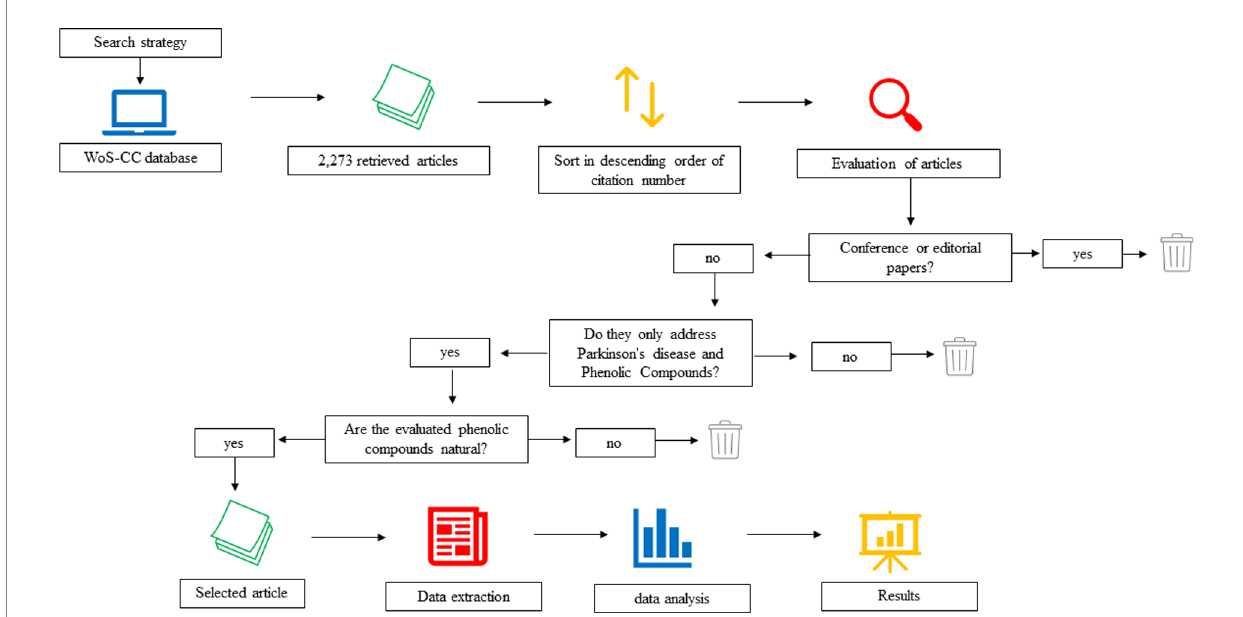
FIGURE 1 Methodological flowchart of the search, evaluation and selection of the most cited articles on PD and PC. The search for articles was carried out in WoS-CC, the retrieved articles were sorted in descending order based on the citation number in WoS-CC. The articles were evaluated with the eligibility criteria. Articles that did not address only PD and CP were excluded, as well as articles that did not address natural CP. 100 articles were selected and the necessary data for bibliometric analysis were extracted. Data were analyzed quantitatively and qualitatively using descriptive statistics. Software with VosViewer and Mapchart contributed to illustrate the results of the bibliometric